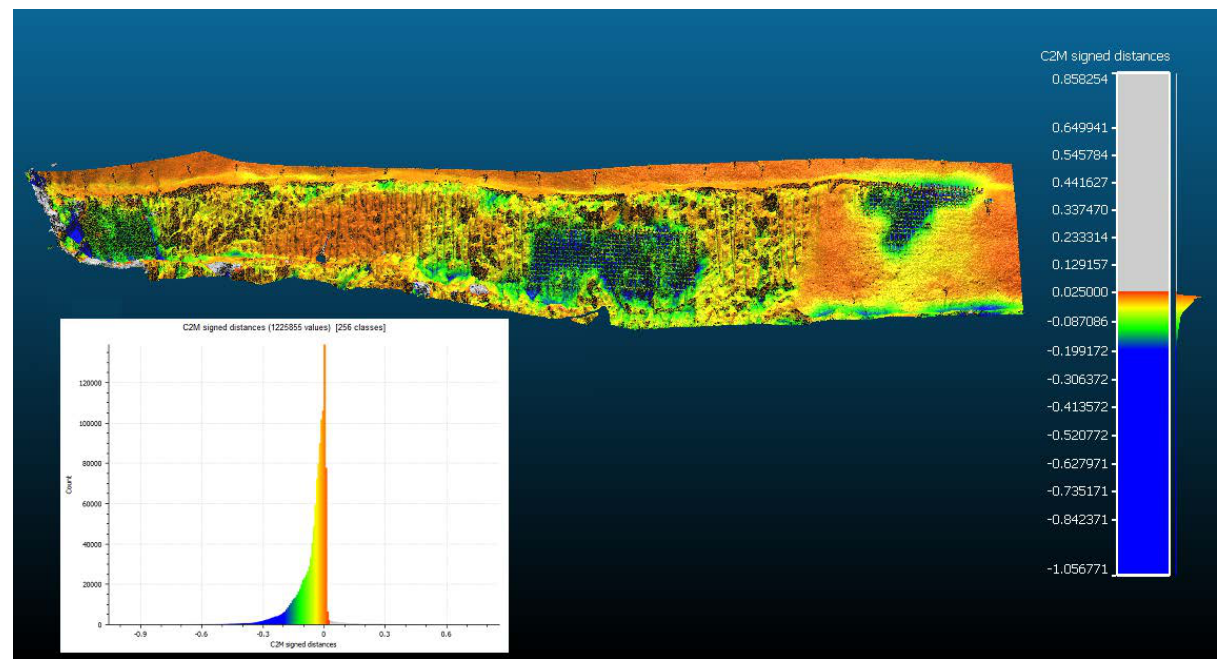
Figure 10. Point cloud of signed distances between the two surveying epochs. The last epoch was used as a reference for distance calculation and as a result most of the points are below zero. The overlaid histogram shows the thickness estimation more in